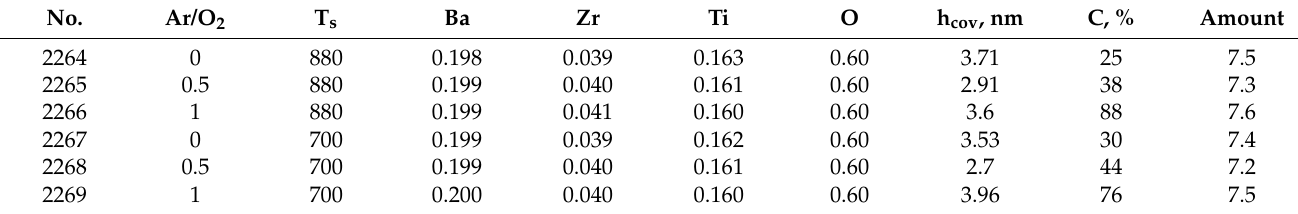
Table 1. Characteristics of island films investigated.